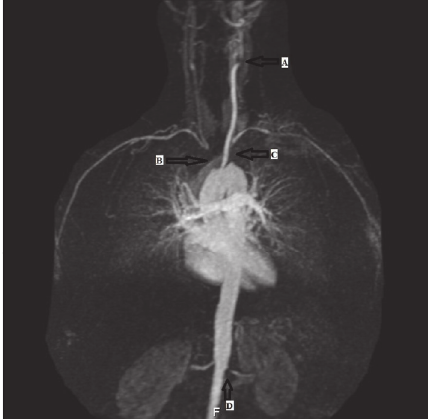
Figure 2: MR angiography of the patient (A: left carotid artery bifurcation stenosis, B: occlusion of brachiocephalic trunk, C: segmental stenosis of left subclavian artery, and D: left renal artery stenosis).